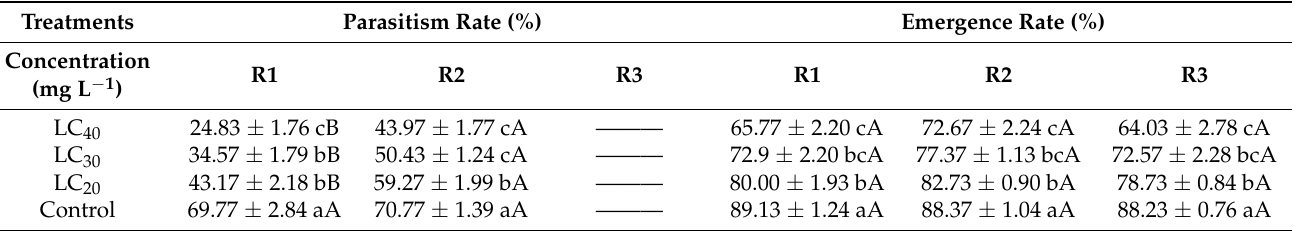
Table 2. The parasitism rate (%) and emergence rate (%, mean ± SE) of Tetrastichus howardi at different concentrations of indoxacarb were treated with three